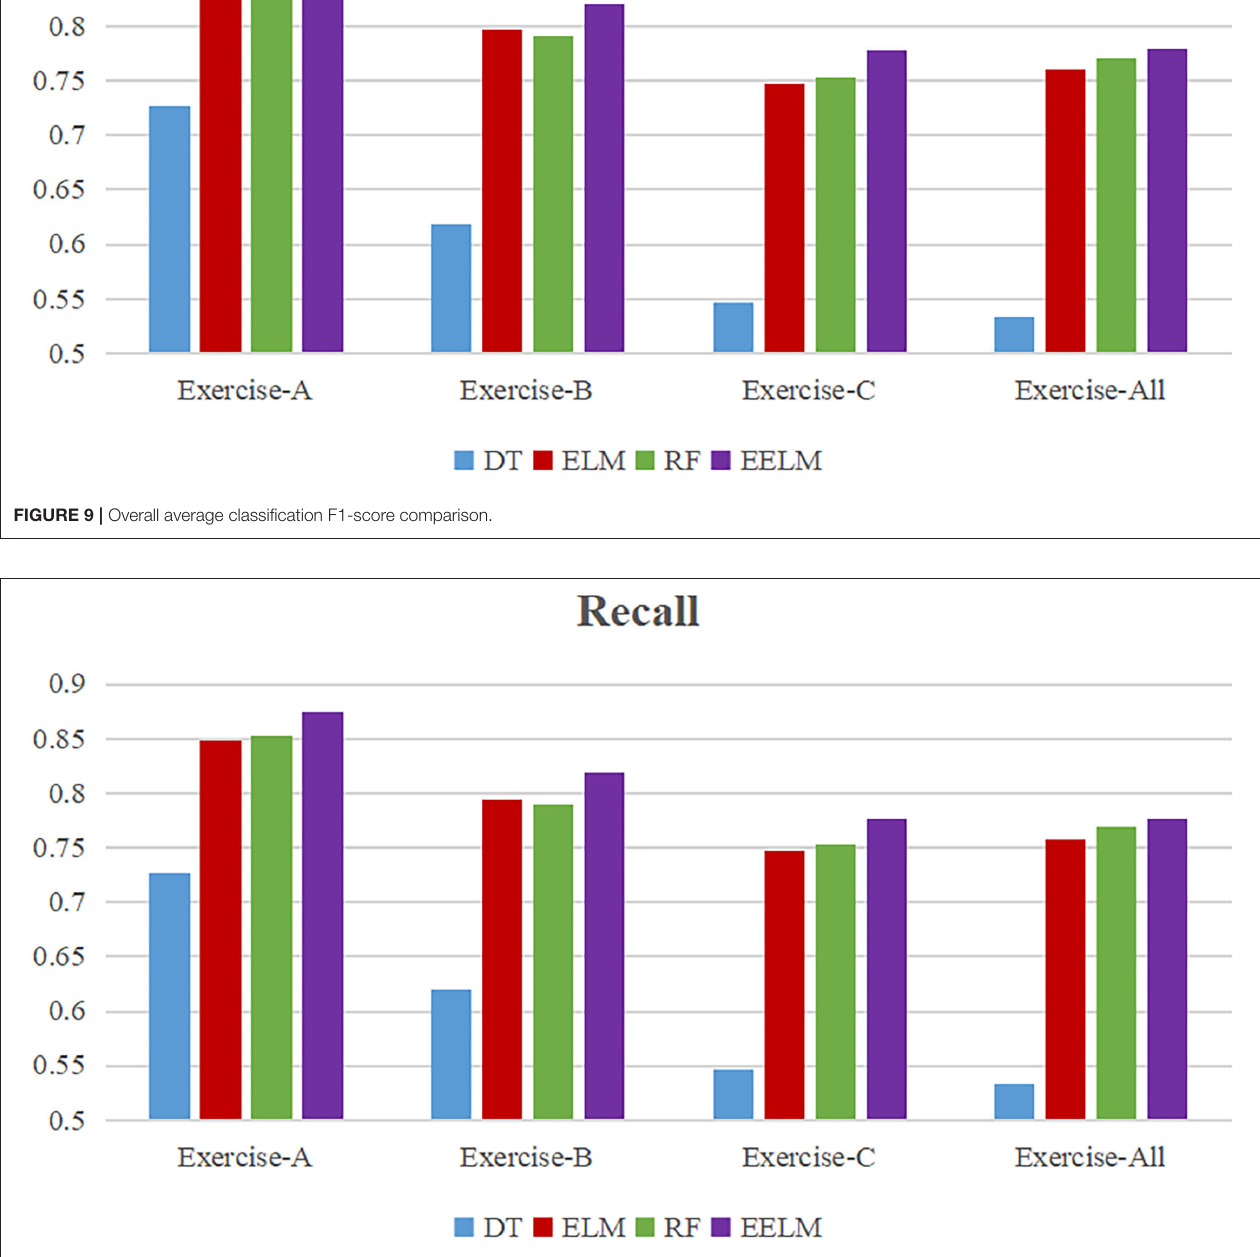
FIGURE 10 | Overall average classification recall